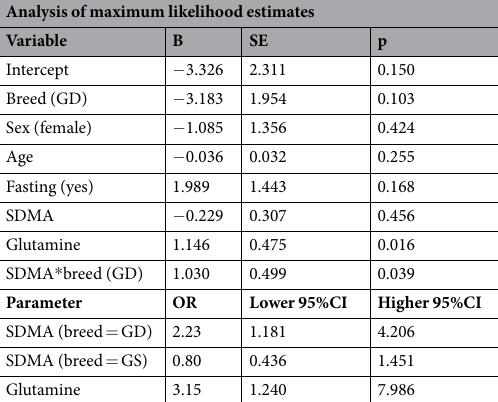
Table 4. Results of multiple logistic regression model for the top discriminating metabolites SDMA and glutamine in addition to breed, sex, age and fasting status. B = coefficient, SE = standard error, GD = Great Dane, SDMA = symmetric dimethylarginine. DF = 1. Odds ratio estimates of the significant variables in the model. Odds ratio of SDMA is given in the subgroups of Great Danes and German Shepherd because of the interaction between breed and SDMA. OR = odds ratio, CI = confidence interval, SDMA = symmetric dimethylarginine, GD = Great Dane, GS = German Shepherd. Pearson goodness-of-fit statistics: value/ DF = 0.781, p = 0.806 Model fit statistics: AIC = 39.651 ROC association statistics: AUC = 0.930, lower 95%CI = 0.850, higher 95%CI = 1.000.